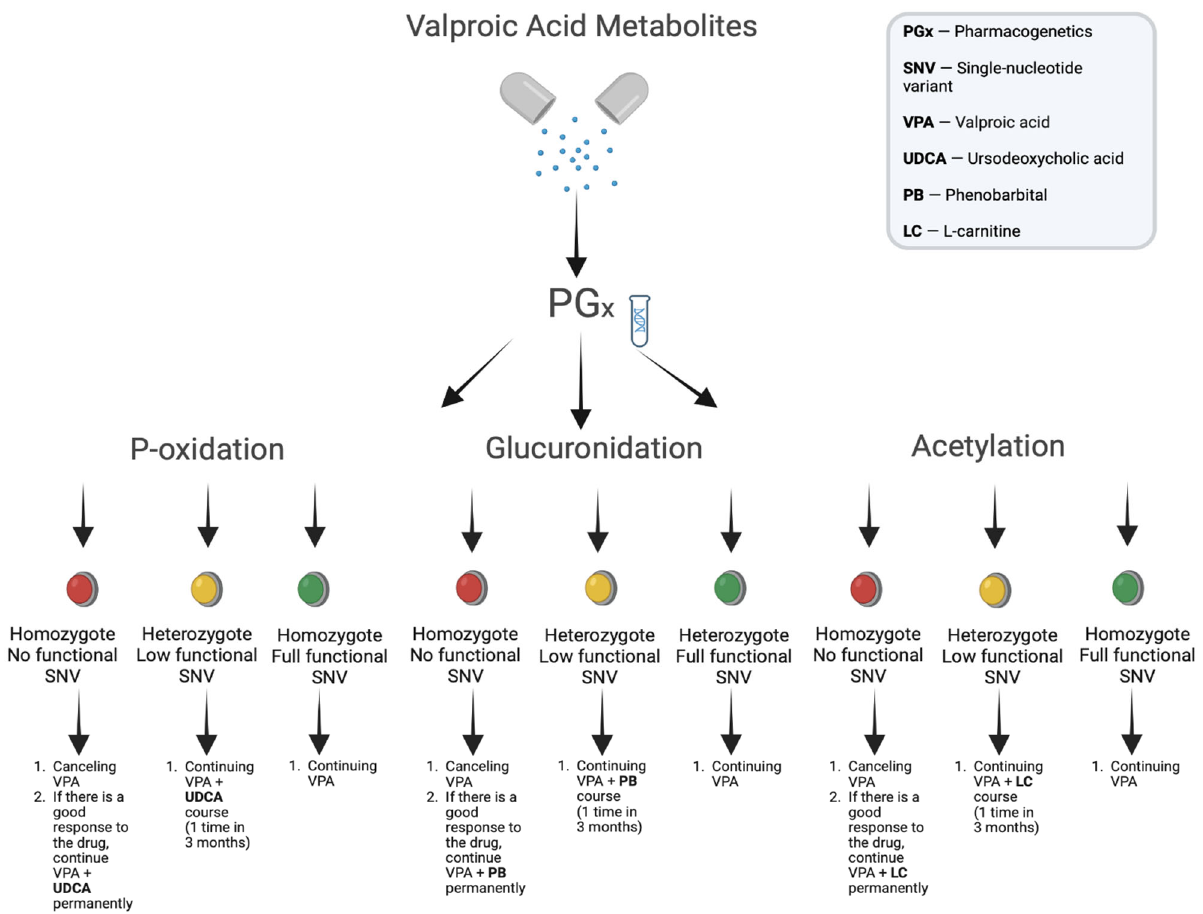
Figure 6. Pharmacogenomic approach to assessing the risk of development- and correction-adverse reactions induced by valproic acid metabolites.